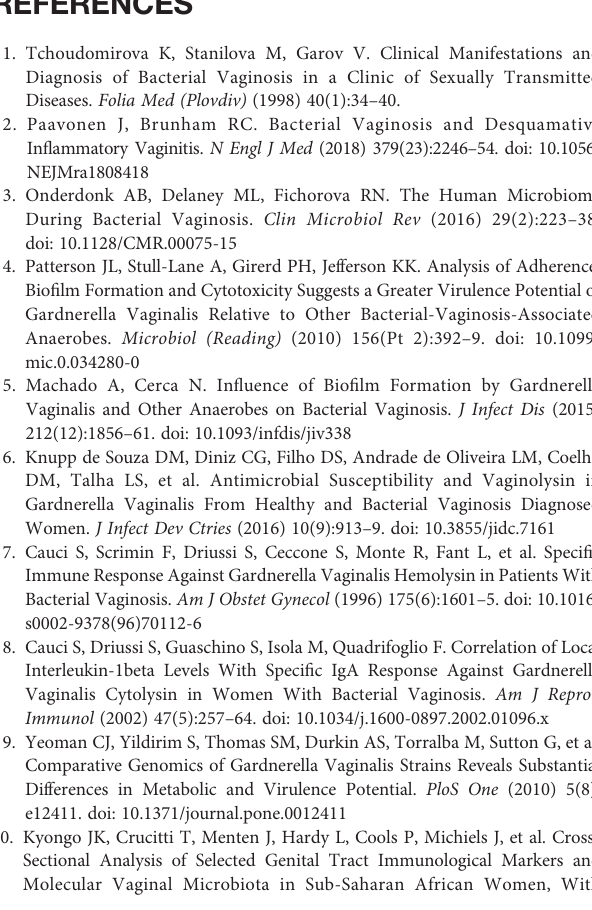
(C) Macrophage surface marker (CD206) was detected by fl ow cytometry after CM treatments. The mean fl uorescence intensity (MFI) is shown. The black bar